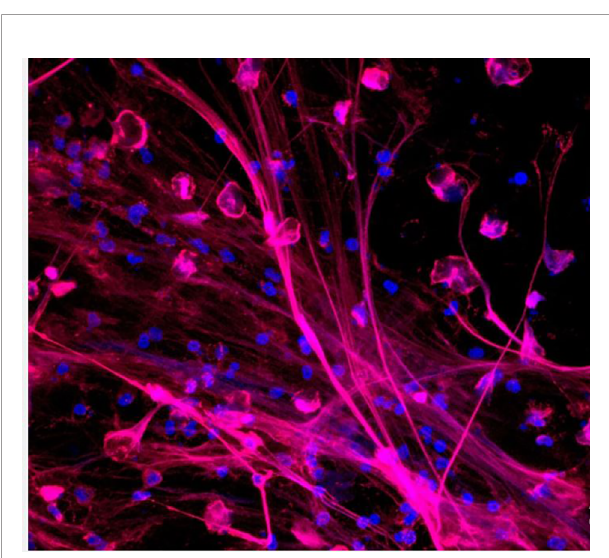
FIGURE 2 | Neutrophils releasing neutrophil extracellular traps (NETs). NETs are stained to visualize neutrophil myeloperoxidase (red) and DNA (blue)